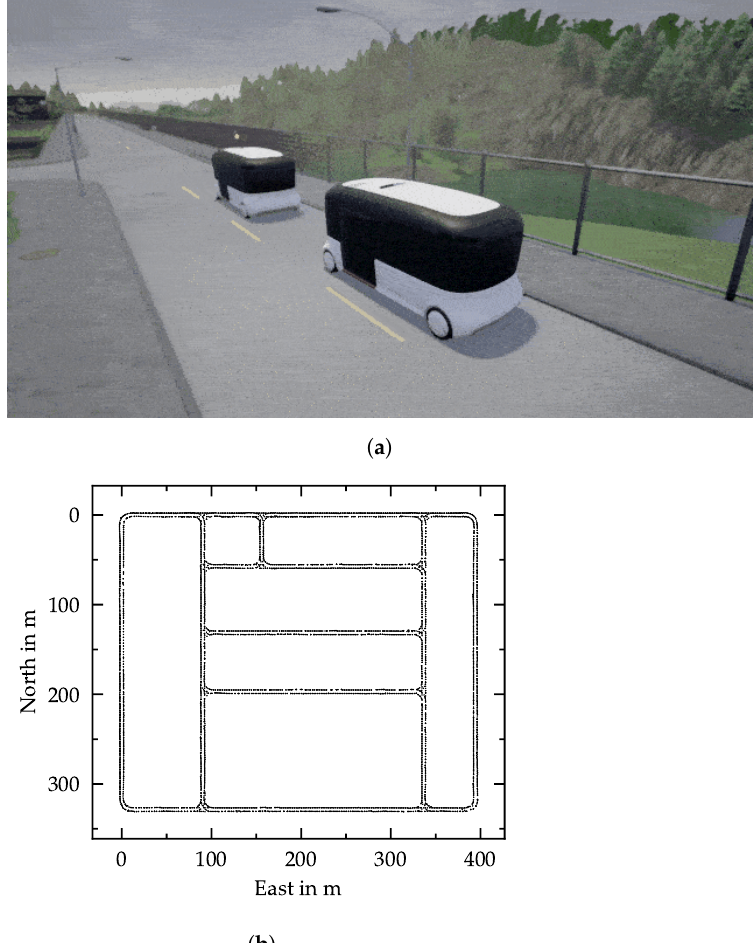
Figure 4. Simulation environment. ( a ) Two-vehicle platoon with minibuses used for dataset recording in the CARLA simulator [18]. ( b ) Map of Town01 , which serves as the urban environment for the train- ing and validation dataset recording. Each point represents a position visited by the vehicles during dataset recording. Smaller deviations from the center line are due to injected noise (lateral